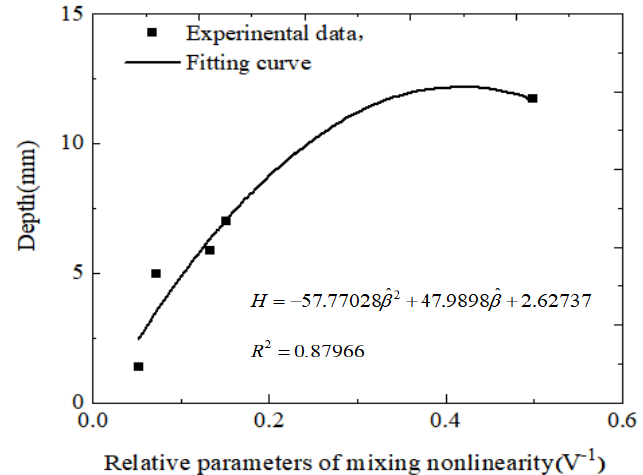
Figure 23. Relationship between nonlinear mixing relative parameters and crack depth.